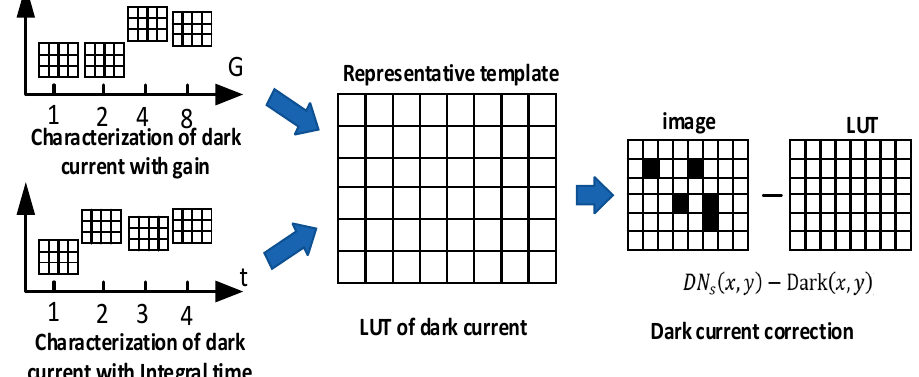
Figure 3. Workflow to obtain the lookup table (LUT) of dark current and dark current